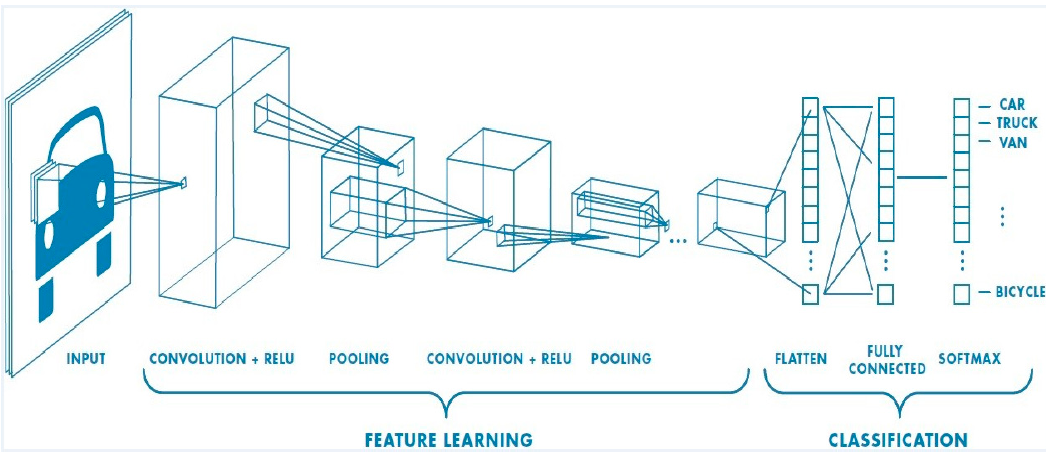
Figure 14. The a rchitecture of a convolutional neural network [58]. Figure 14. The architecture of a convolutional neural network